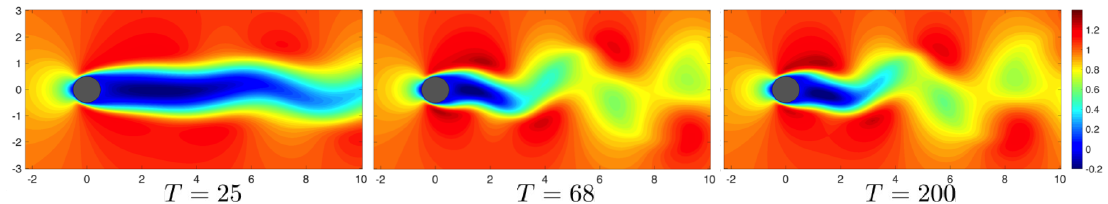
Figure 4. Isocontour plots of the stream-wise velocity component for cylinder flow at Re = 100 and T = 25,68, and 200, showing the evolution of the flow field. Here, T represents the time non-dimensionalized by the advection